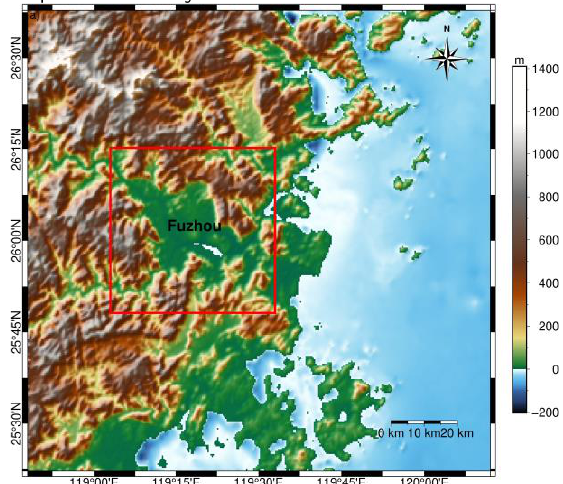
Figure 1 . Geographical and topographic information of the study area, located in the Fuzhou